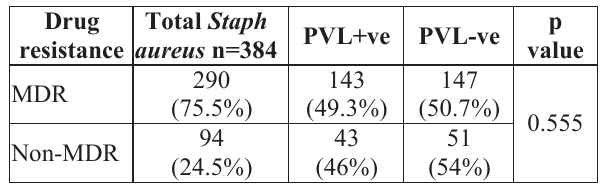
Table-5: Relationship of MDR and PVL gene